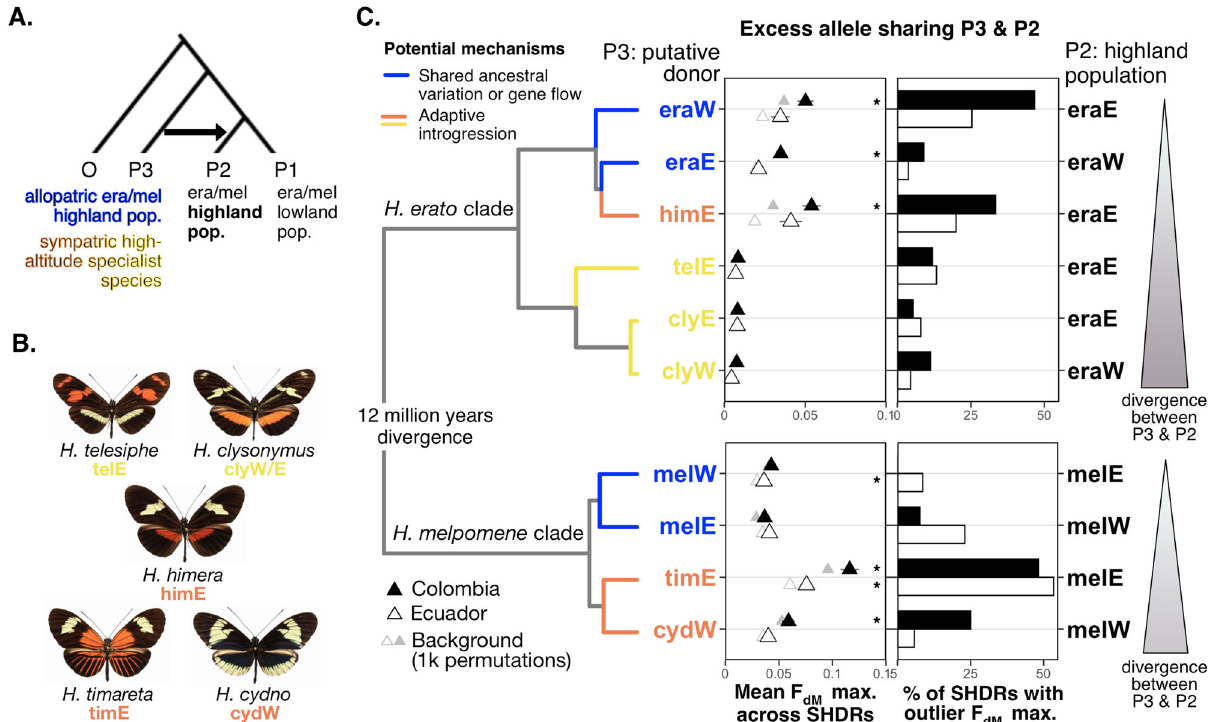
Fig. 6 | Many SHDRs were sourced from standing variation and putative adaptiveintrogressionfromhighland-specialistspecies.A Treeusedtoestimate F dM values per 50kb window across the genome in each comparison, which when positive represents excess allele sharing between P2, a highland H. erato or H. melpomene population, and P3, an allopatric highland population of the same species or a sympatric high-altitude specialist species, compared to a lowland population (P2). Colours of P3 populations or species indicate the potential mechanism driving the excess allele sharing, either intraspeci fi c shared ancestral standing variation (blue) or adaptive introgression from closely (orange) or dis- tantly related (yellow) high-altitude specialist species. B Putative donor (P3) high- altitude specialist species. C Excess allele sharing at SHDRs between P3 (putative highland donors, left y axes) and P2 (putative highland recipients, right y axes) across the H. erato (top) or H. melpomene (bottom) comparisons (phylogeny from Kozak et al.) 1,38 . Left panel shows mean maximum F dM (±S.E.) across SHDRs